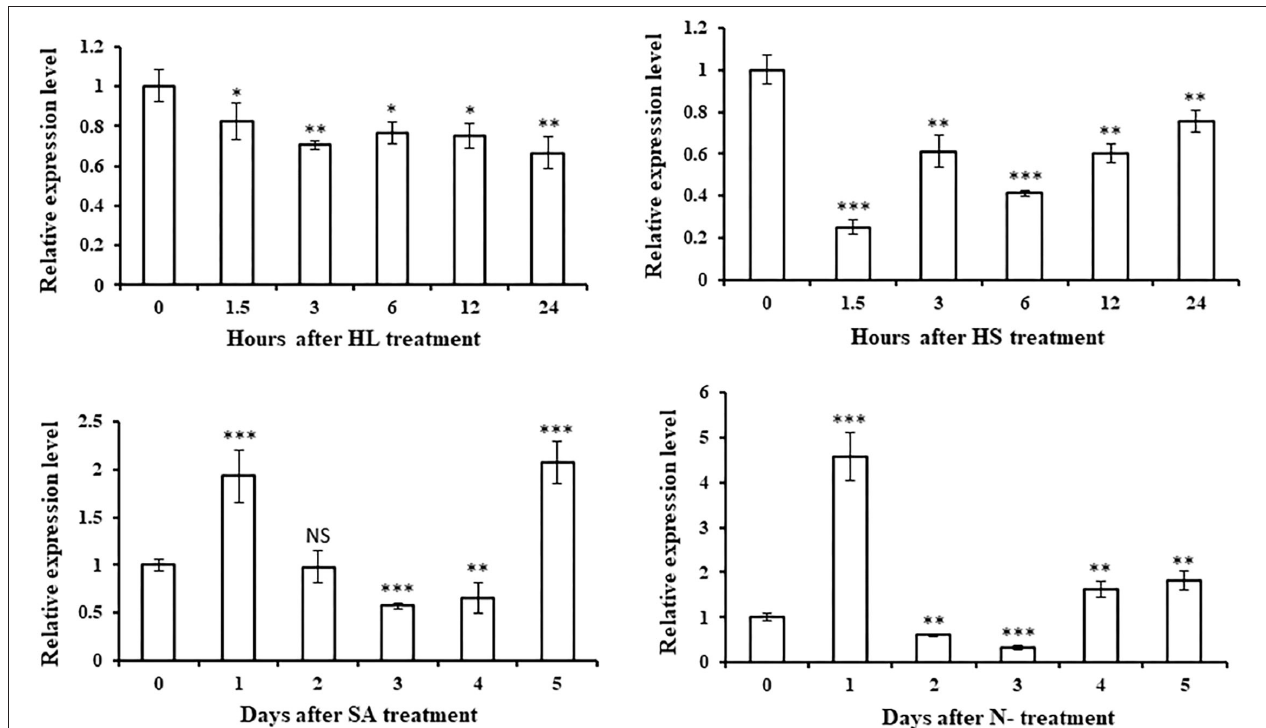
FIGURE 4 | The relative expression levels of HpGCN5 under multiple abiotic stresses quantified by qRT-PCR assay. HL indicates the high light stress, HS indicates the high salt stress, SA indicates the salicylic acid stress, and N- indicates the Nitrogen-depletion stress. *, **, *** indicates the statistical significance between the treatment and control at the level of 0.05, 0.01, and 0.001, respectively. NS indicates no statistical significance.